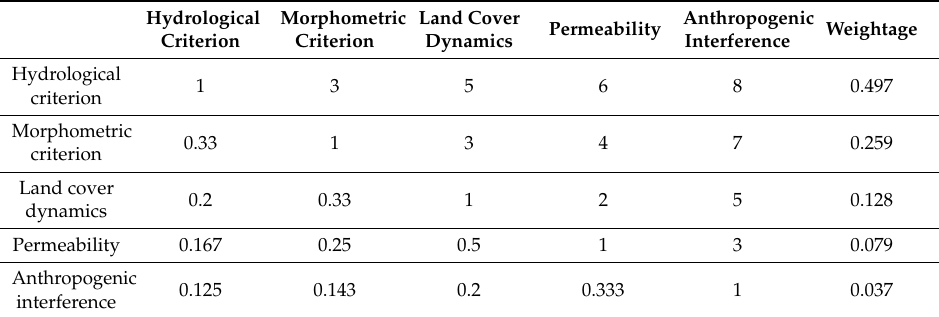
Table 4. Pair-wise comparison matrix, and final weights ( w i ) for flood susceptibility criteria.